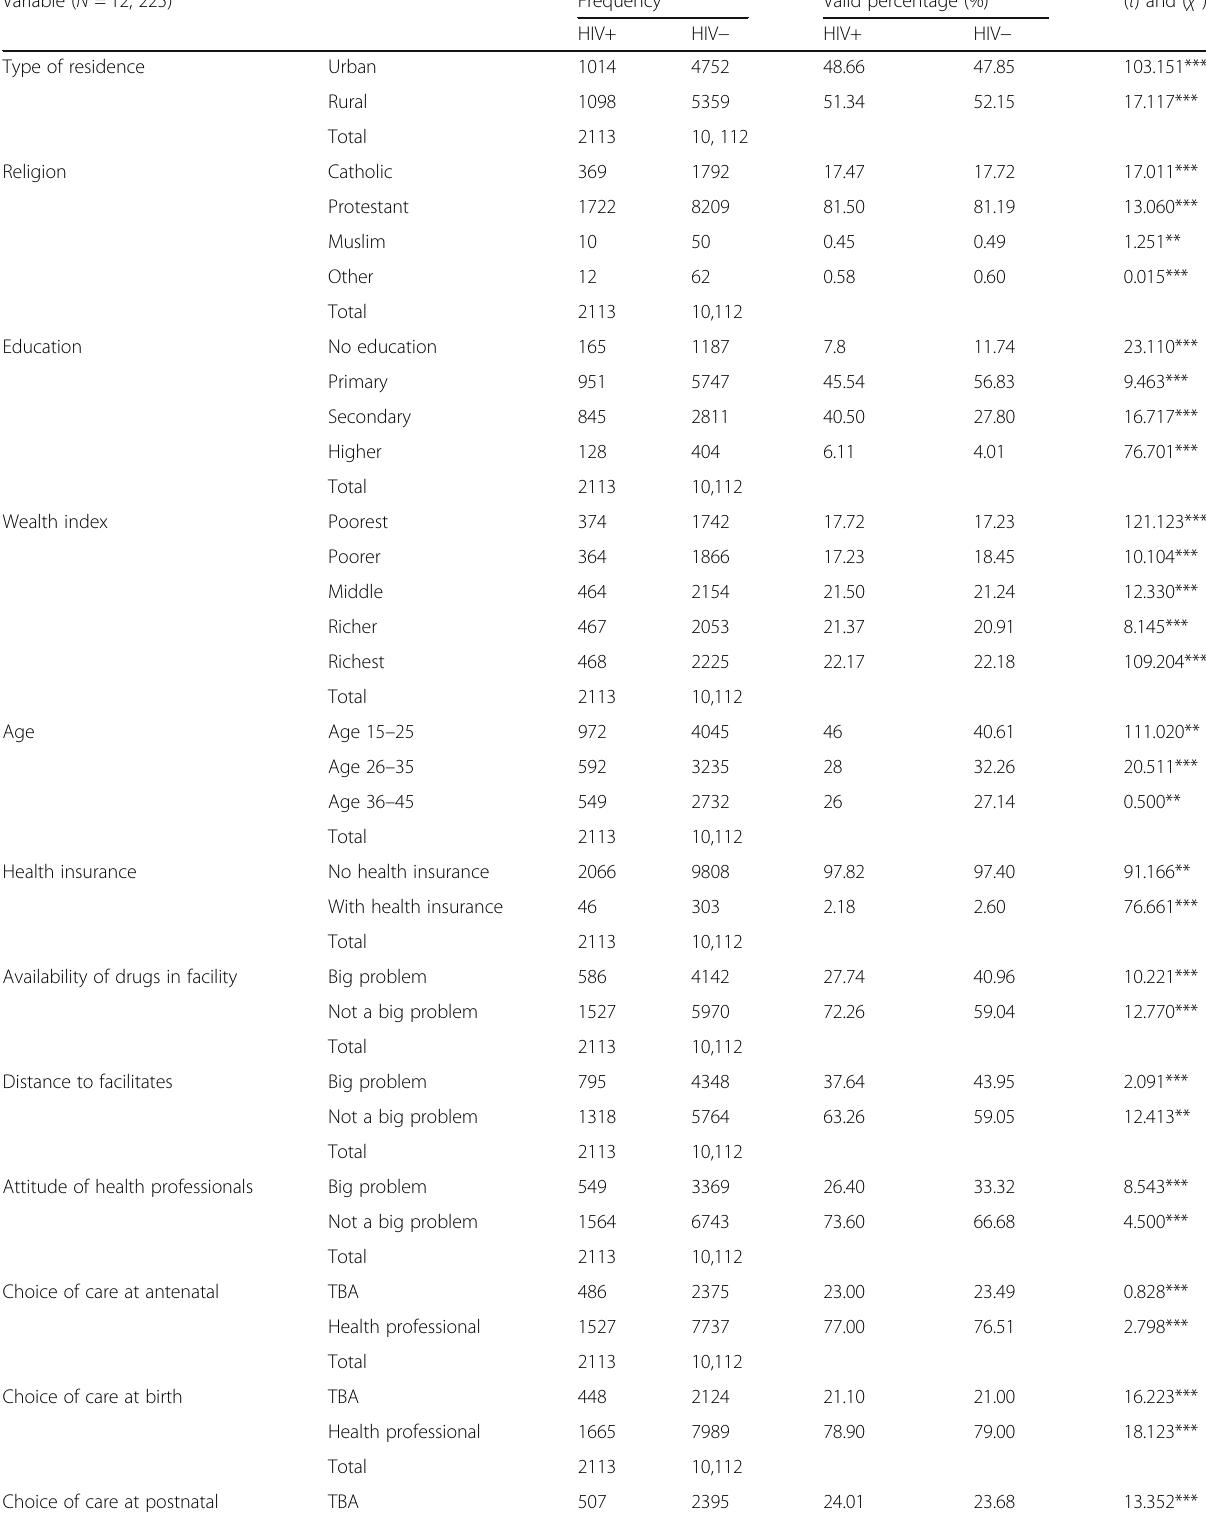
Table 1 Summary of characteristics (differences and similarities) between HIV-positive and HIV-negative populations Variable ( N = 12,